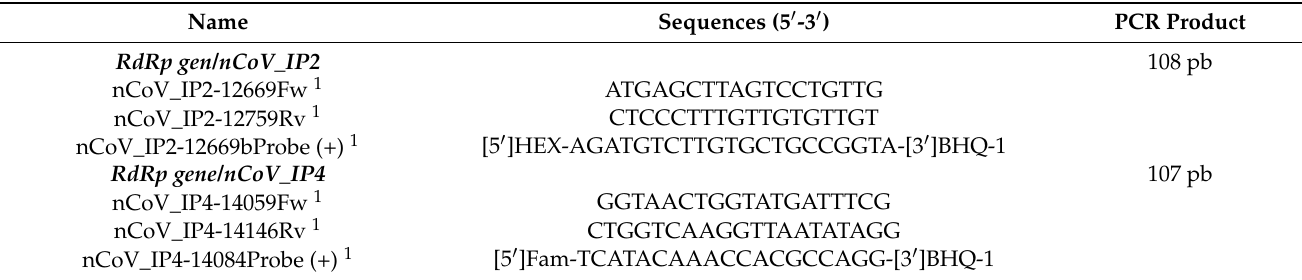
Table 1. Real-time RT-PCR primers and probes for the detection of SARS-CoV-2.